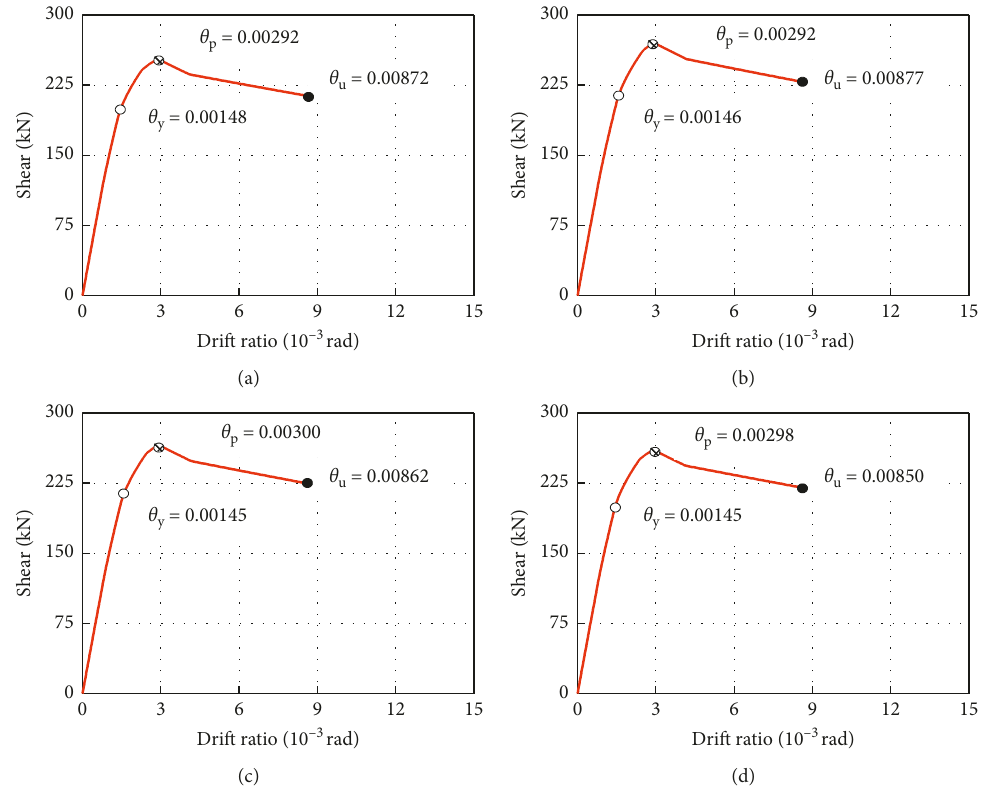
Figure 9: Capacity curves considering the vertical seismic effect. (a) Site I. (b) Site II. (c) Site III. (d) Site